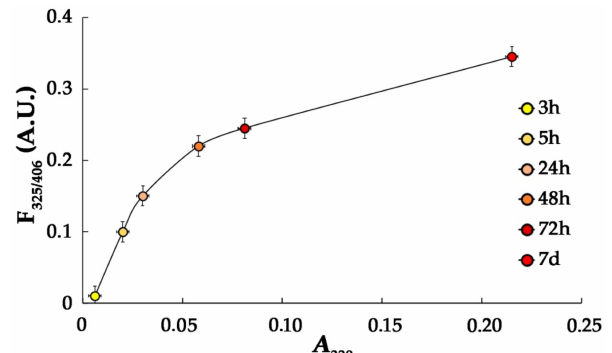
Figure 1. Plot of fluorescence ( λ ex / λ em = 325/406 nm) versus optical absorbance at 320 nm for HSA-MG at various durations of modification (indicated in the figure). For standard HSA solution A 320 = 0.003; F 325 /F 406 = 0. All measurements were performed in triplicate ( n =